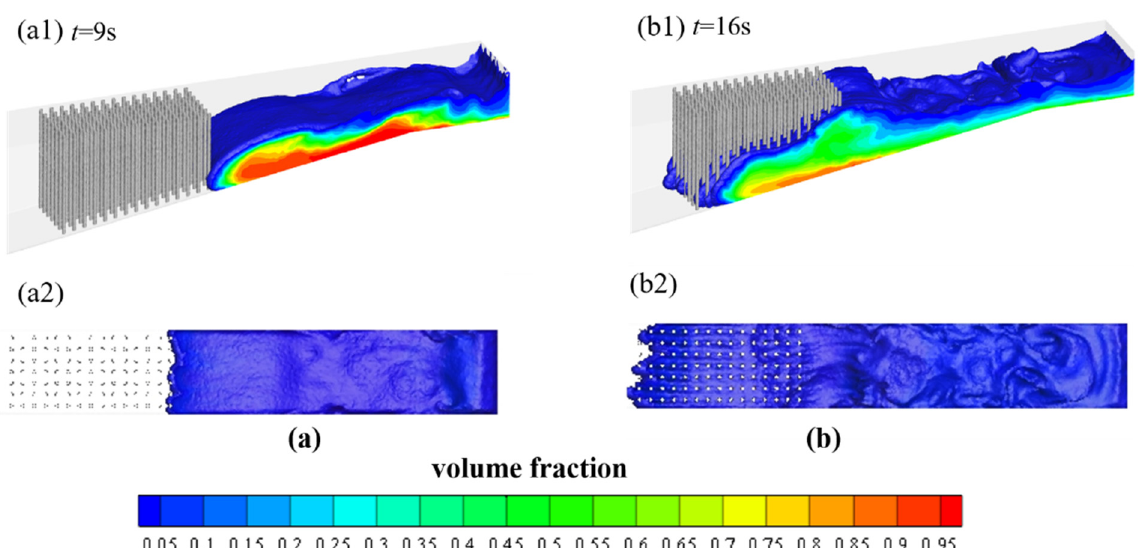
Figure 6. The three-dimensional simulation results of gravity current flowing through emergent vegetation patches along the slope in the stratified environment (Run ES-S3): ( a ) before vegetation patches ( t = 9 s), and ( b ) within vegetation patches ( t = 16 s). Note: ( a1 , b1 ) are the three-dimensional view of the flow, and ( a2 , b2 ) are the top view of the